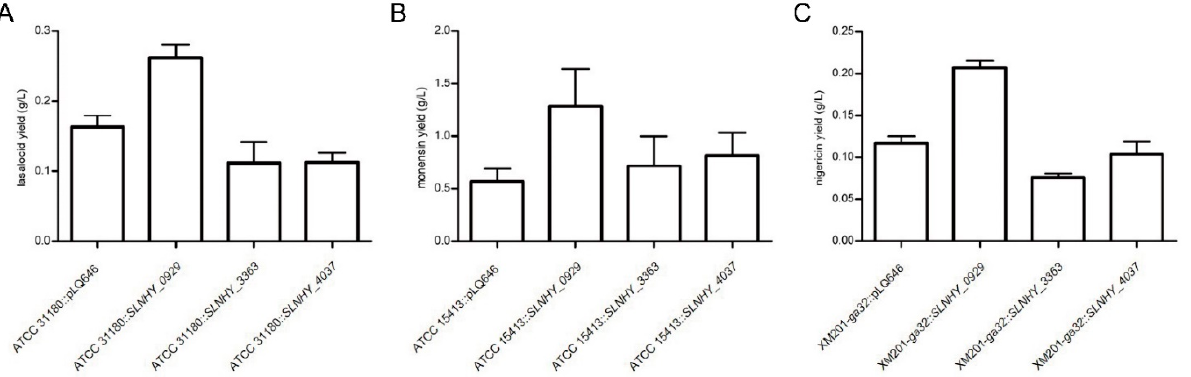
Figure 6. Production of polyether antibiotics with heterologous expressions of exporters in other Streptomyces hosts. ( A ) Lasalocid production of S. lasaliensis mutants. ( B ) Monensin production of S. cinnamonensis mutants. ( C ) Nigericin production of S. hygroscopicus mutants. pLQ646, integrative vector with kasO p* promoter.